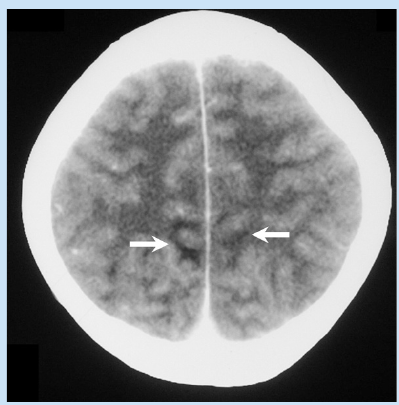
Fig. 1. Axial post-contrast CT scan of the brain shows bilateral parafalcine posterior parietal white matter low densities (arrows) without associated